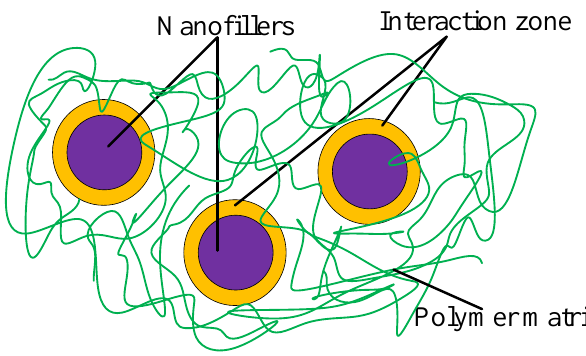
Figure 12. Simple diagram demonstrating the components of polymer nanocomposites [73].